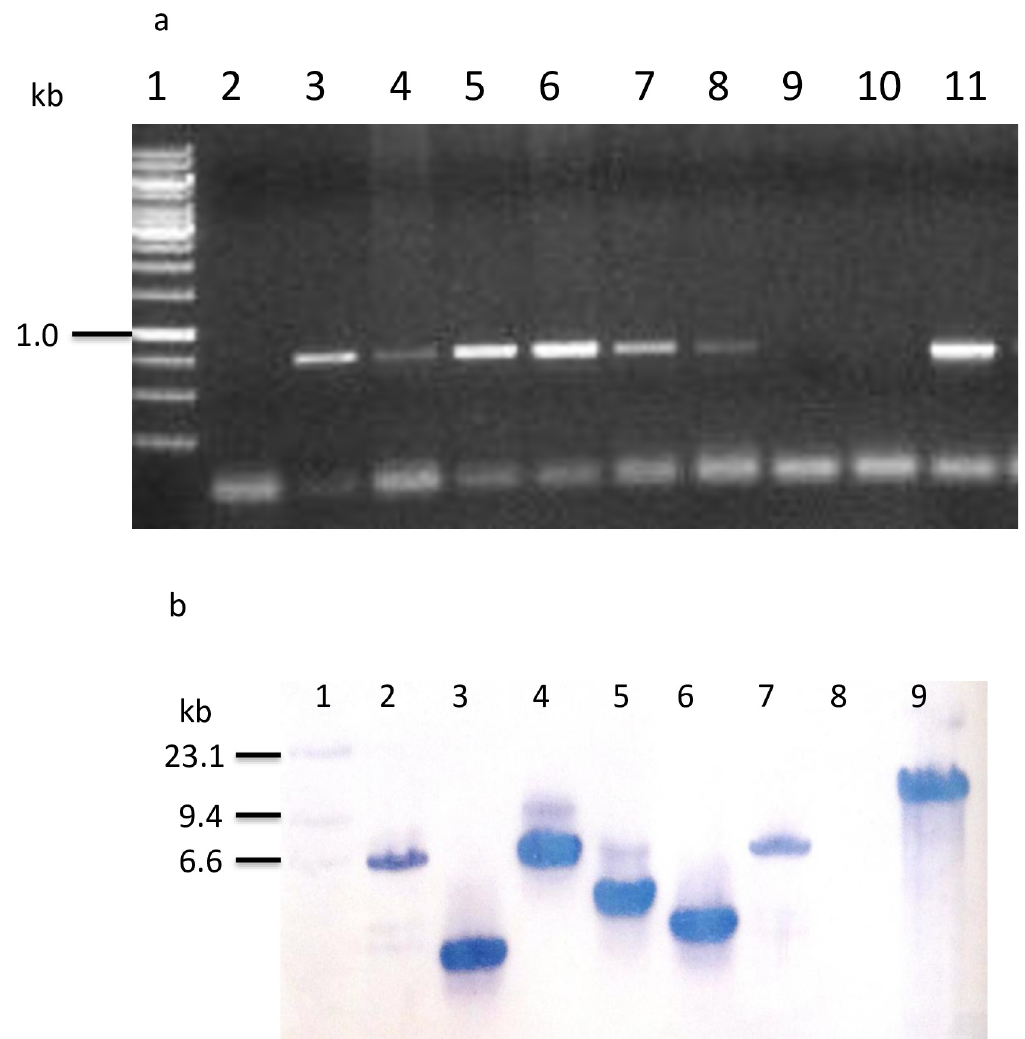
Fig 2. Presence of cm Vip3Aa in transgenic chickpea lines. (a) PCR amplification of cm Vip3Aa gene segment [L1: 1kb DNA ladder, L2: Control (DCP 92–3), L3: VPS 13, L4: VPS 14, L5: VPS 47, L6: VPS 57, L7: VPS 66, L8: VPS 77, L9: No